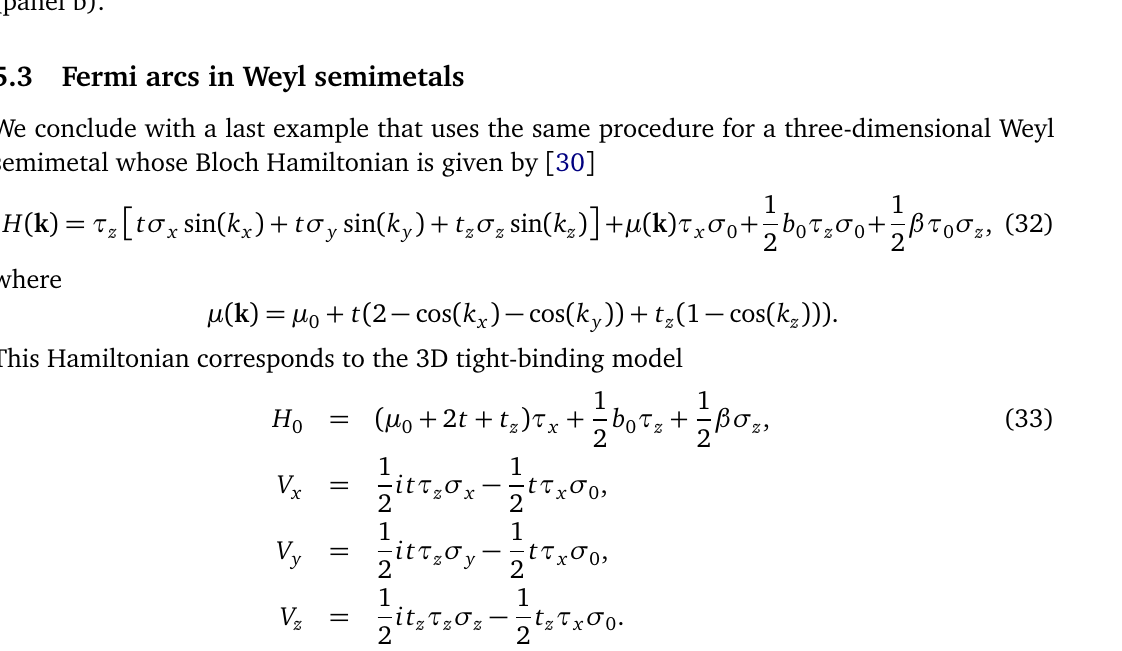
Figure 9: Andreev bound states in a Josephson junction as a function of the superconducting phase difference ϕ . Parameters are set to ∆ = 0.5, µ = 0.5, V = 0.5. B = 1 in the topological regime (panel a) and B = 0.4 in the trivial one (orange), α so (panel